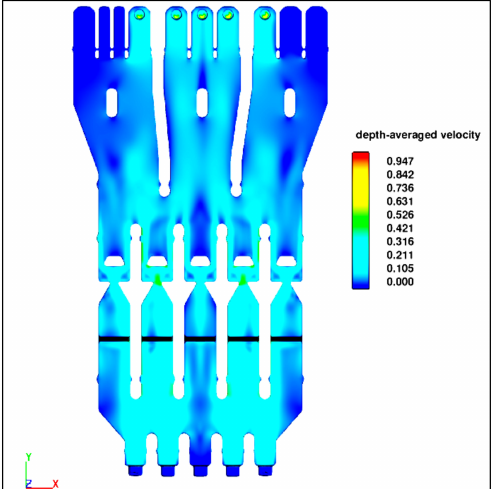
Figure 9. Velocity contours at the basin for scenario III—3D model.